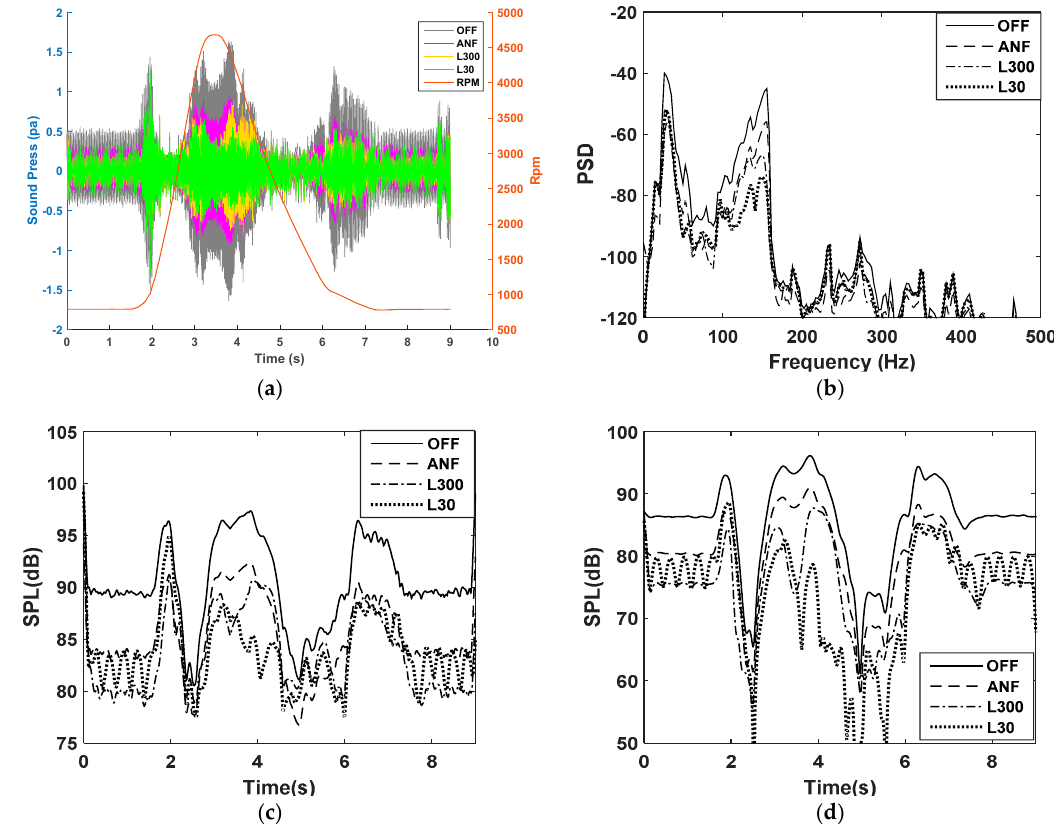
Figure 16. Comparison of sound pressure level (SPL) controlled actively by the FxLMS-algorithm-based adaptive notch filter and the OW-FxLMS algorithm at the driver seat. The driving conditions are a no-load condition and fast run-up. ( a ) Time history; ( b ) PSD; ( c ) Overall level of SPL; ( d ) SPL of the second order.